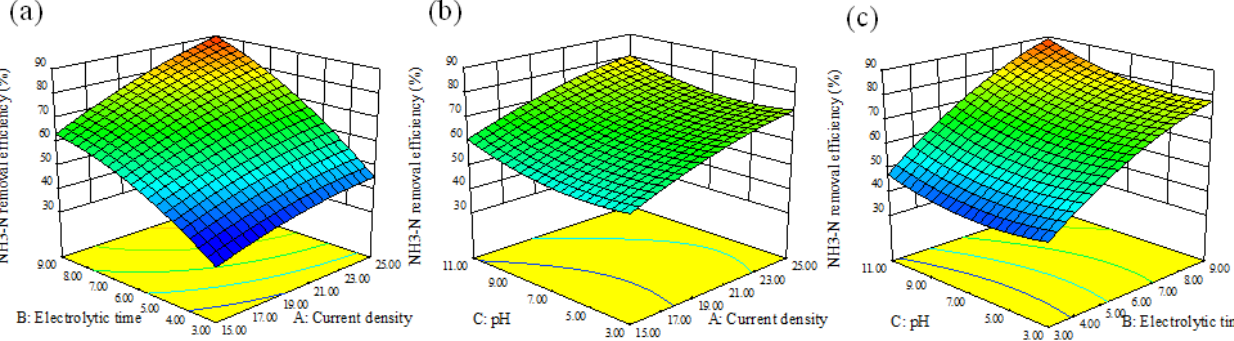
Figure 3. Response surface plots of the combined effects of ( a ) current density and electrolysis time, ( b ) current density and pH, ( c ) electrolysis times and pH on COD removal efficiency.